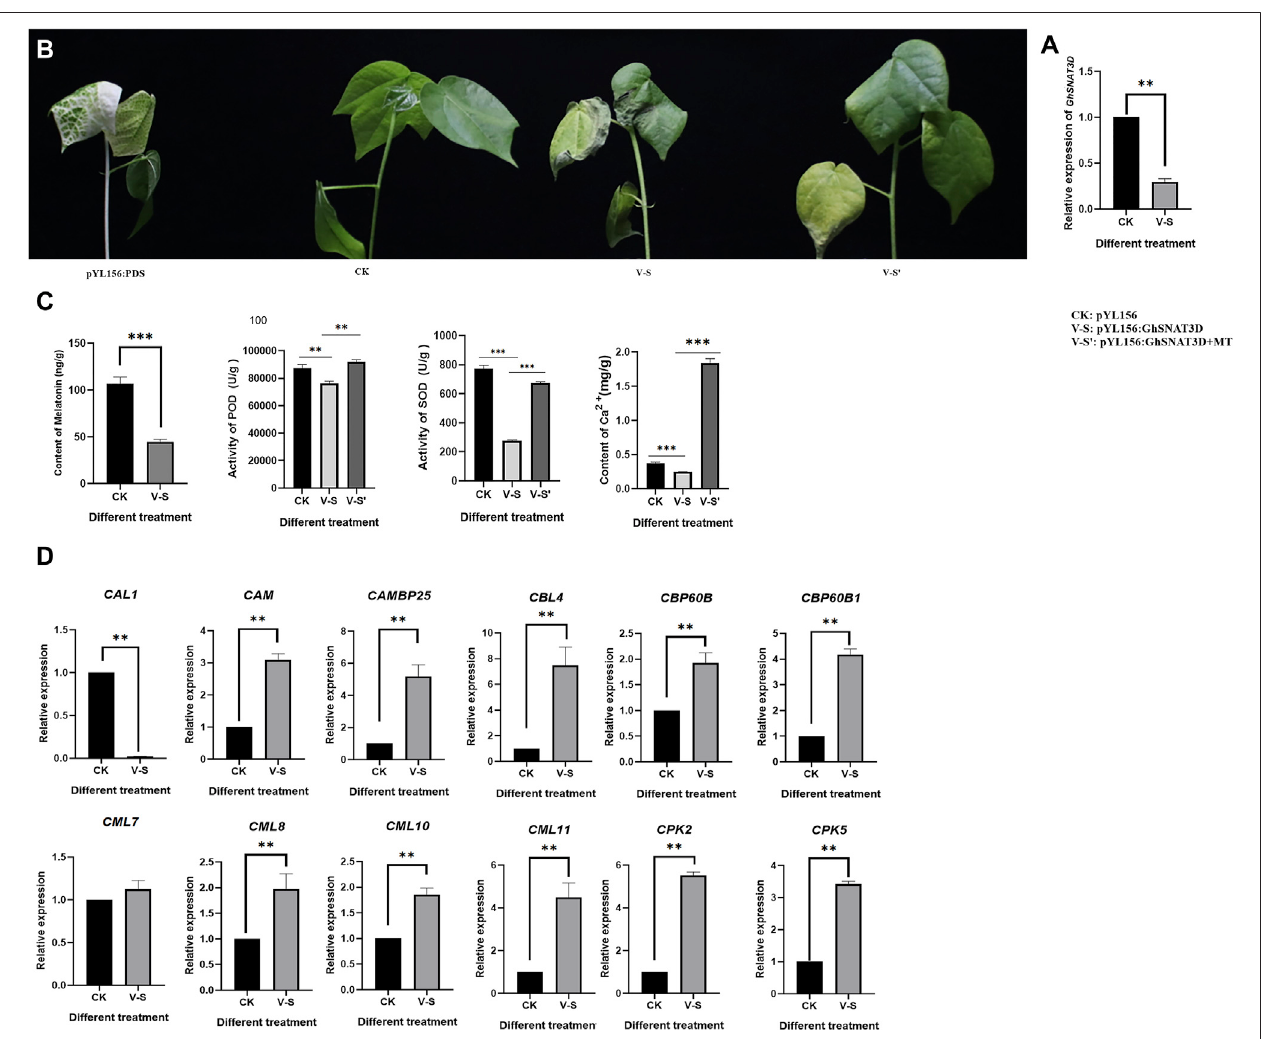
FIGURE8| Functionveri fi cationof GhSNAT . (A) :Detectionof GhSNAT3D silencingef fi ciency. (B) :Phenotypiccomparisonof GhSNAT3D silencedplantundersalt stress. (C) :Detectionofmelatonincontent,PODactivity,SODactivityandCa 2+ contentof GhSNAT3D silencedplants. (D) :Detectionofdownstreamgeneexpressionof Ca 2+ signal transduction in GhSNAT3D silenced plants. * p < 0.05, ** p < 0.01 and *** p <